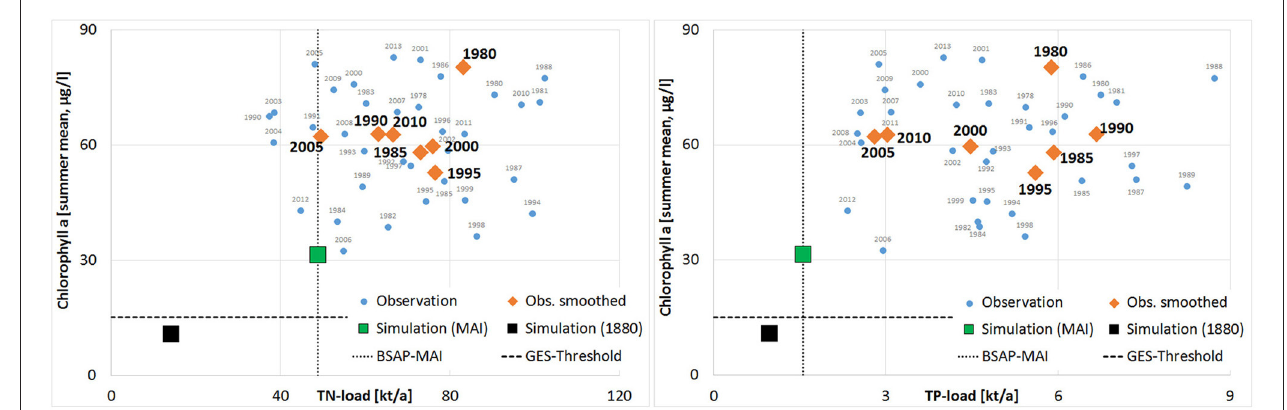
FIGURE 6 | Observed summer Chl-a at station KHM (Small Lagoon) as function of the annual TN and TP inputs to the entire lagoon (blue cycles—annual values; orange diamonds—averaged over 5 years). Additionally are shown: (i) MAI of HELCOM BSAP and proposed GES-thresholds (black lines); (ii) pre-industrial simulated water quality and nutrient loads (black square); (iii) simulated water quality using MAI (green, including a moderate climate change). Note that Chl-a of 1979 (149 µ g/l) was excluded.